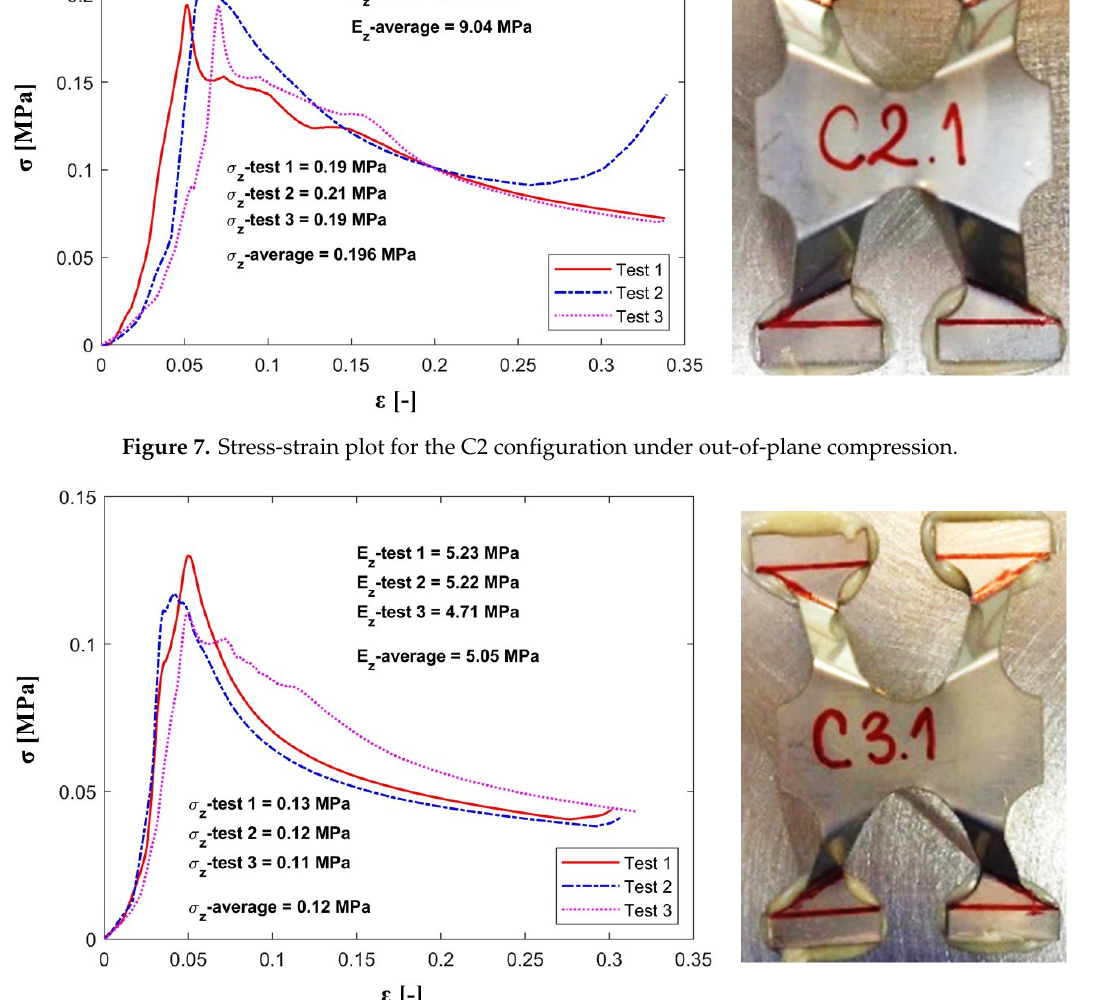
Figure 8. Stress-strain plot for the C3 configuration under out-of-plane compression.